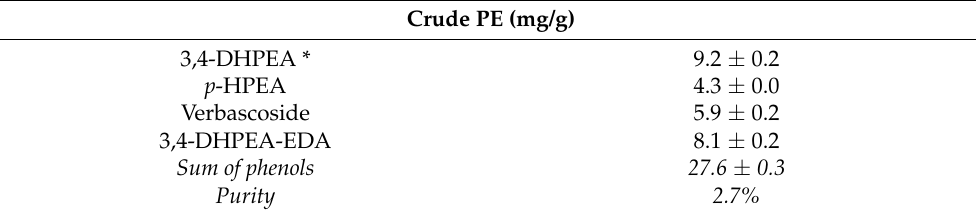
Table 1. Composition of spray-dried crude phenolic extract